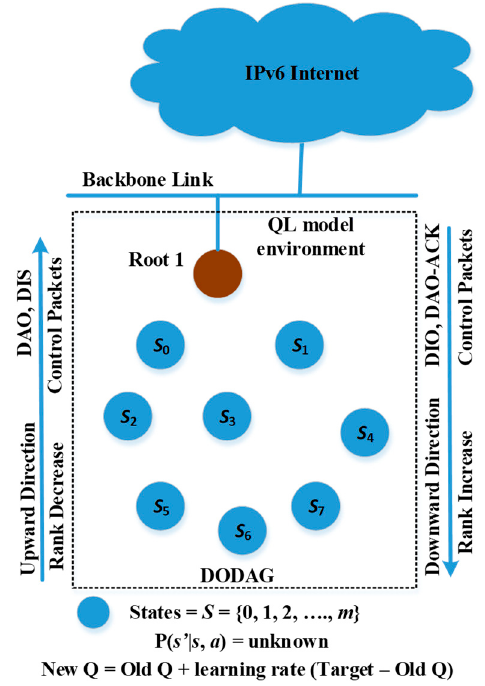
Figure 3. Q-learning model environment for intelligent IoT system device.